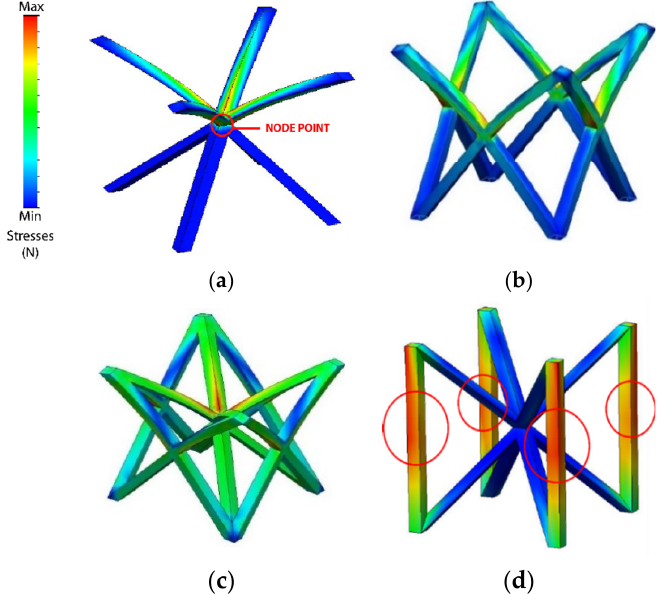
Figure 5. Compression stress analysis of the different cell topologies; ( a ) BCC; ( b ) FCC; ( c ) FBCC; ( d ) BCCz. ( d )